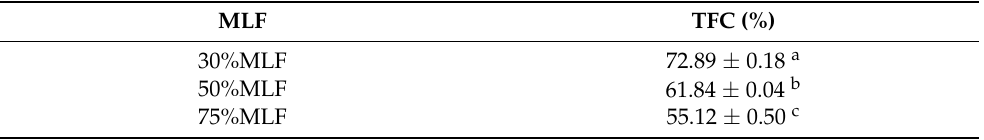
Table 2. Analysis of the total flavonoid content (TFC) of the